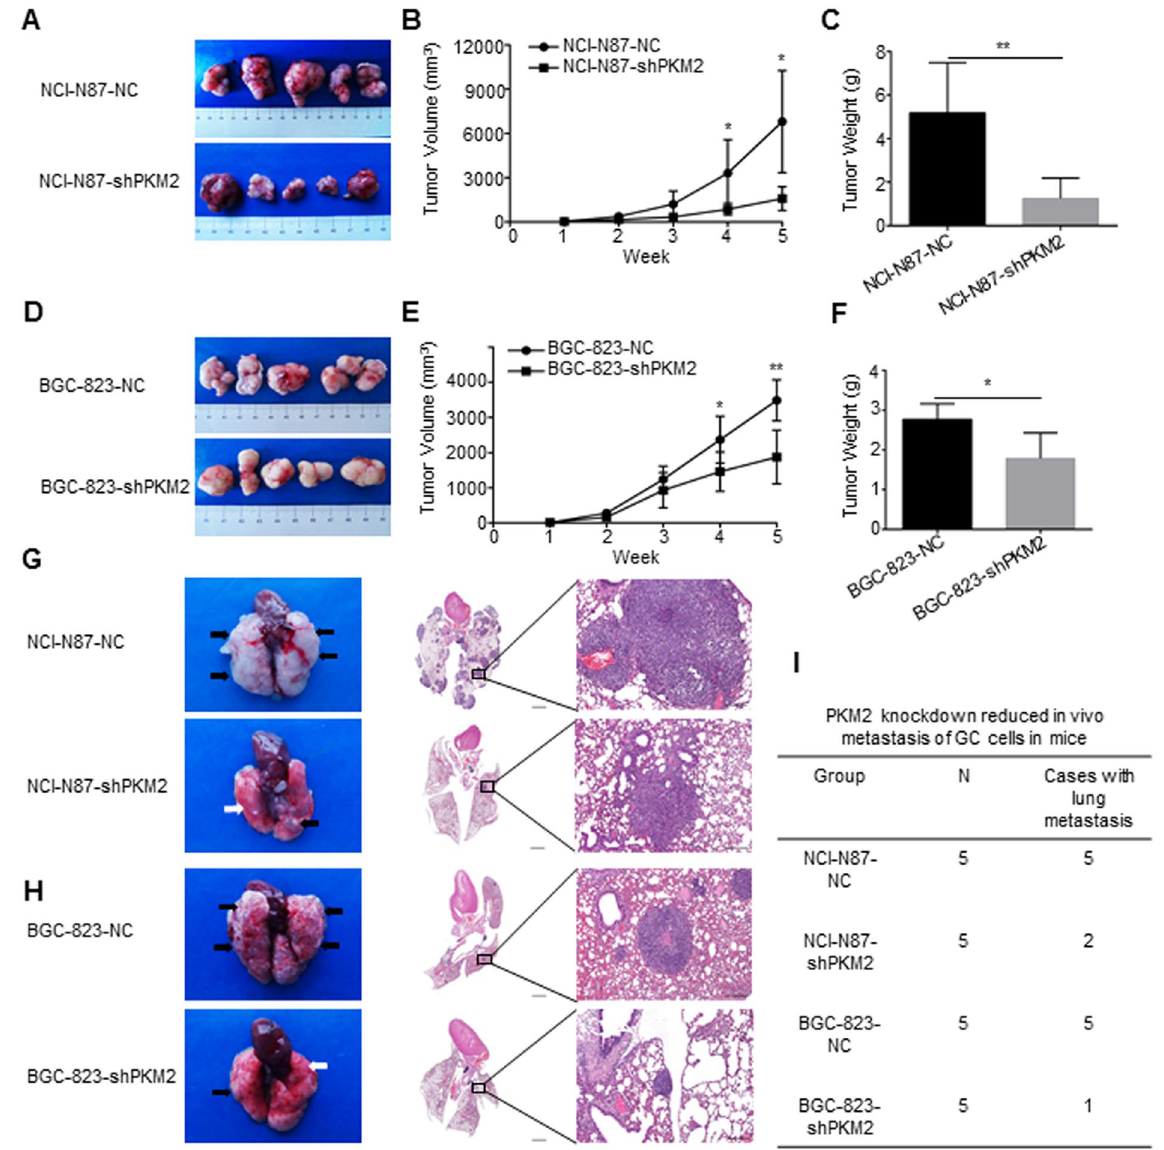
Figure 4. PKM2 knockdown reduces xenografts growth and lung metastasis of NCI-N87 and BGC-823 cells. ( A ) Tumor xenografts formed by implanted NCI-N87 cells with different expression levels of PKM2. ( B and C ) Tumor volume and weights of xenografts in subcutanea of nude mice were measured. Error bar indicated standard deviation (n = 5), Error bar indicated standard deviation (n = 5). ( D ) Tumor xenografts formed by implanted BGC-823 cells with different expression levels of PKM2. ( E and F ) Tumor volumes and weights of xenografts in subcutanea of nude mice were measured. Error bar indicated standard deviation (n = 5), Error bar indicated standard deviation (n = 5). ( G ) The images of lung metastasis and H&E stained sections of lung in the groups of NCI-N87 cells with different expression levels of PKM2 were shown. ( H ) The images of lung metastasis and H&E stained sections of lung in the groups of BGC-823 cells with different expression levels of PKM2 were shown. ( I ) Incidences of lung metastasis of each group were shown. n = 5 for each group. Black arrow stood for lung metastasis and white arrow stood for normal lung tissue. Scale bar, 6 × , 2000 μ m. 100 × , 200 μ m. * P < 0.05. ** P <